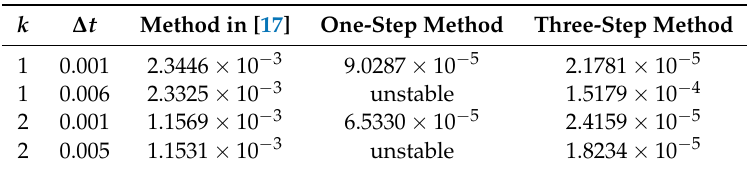
Table 2. The L ∞ error of Example 1 in M = 8.